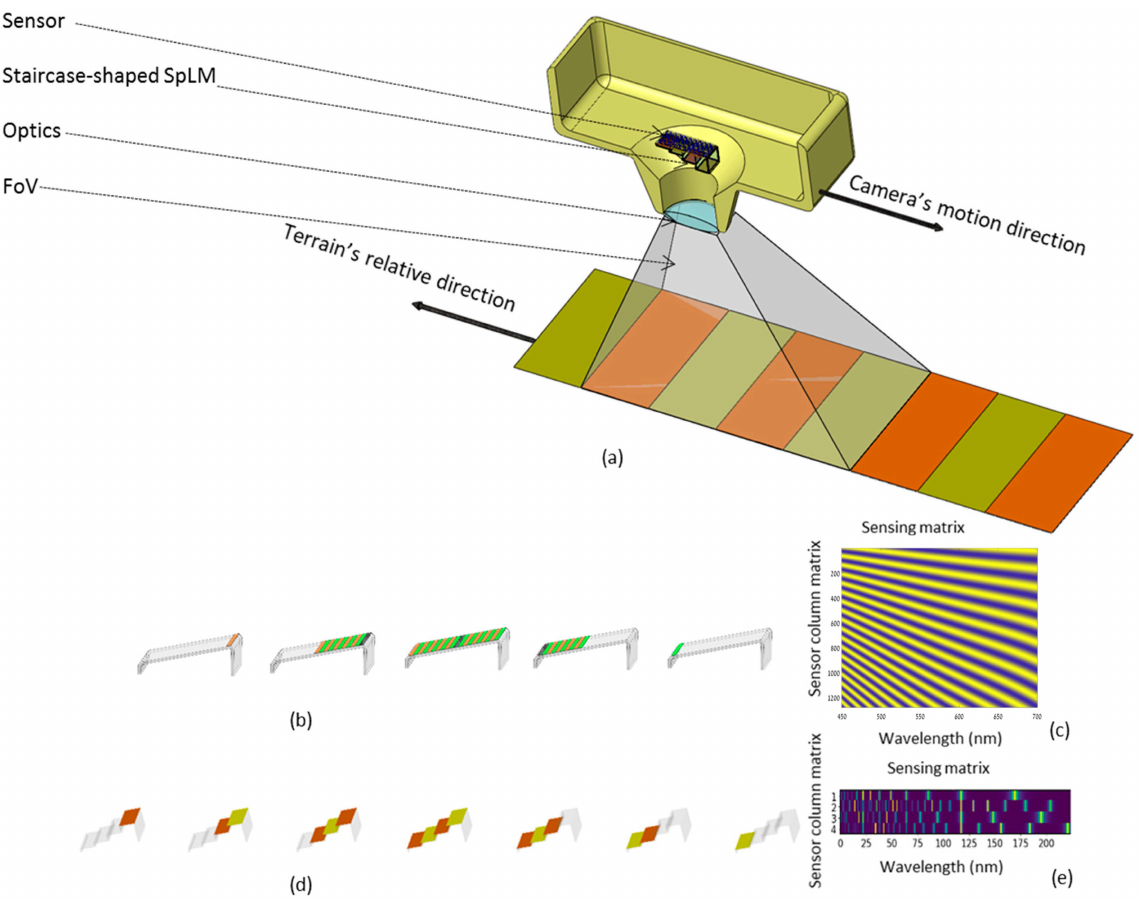
Figure 1. A description of the scanning along-track of a satellite camera equipped with SpLM. ( a ) A satellite camera equipped with SpLM holding a staircase set of mFPR etalons scanning the earth terrain in orbit. Each stair has its own field of view (FoV) capturing a strip of the terrain. ( b ) The wedge-shaped spectral modulator (e.g., the LCC [37]) has a continuous slant, thus, each column of pixels has its own modulation. ( c ) An example of an overcomplete sensing matrix map ( 1250 × 224 ) respective to the wedge-shaped LCC [37]. ( d ) The staircase-shaped mFPR has a discrete slant with a staircase design, where all stairs have equal width, but each stair has a different height, resulting in different spectral modulation. Here, each step has its own FoV and occupies a few pixel